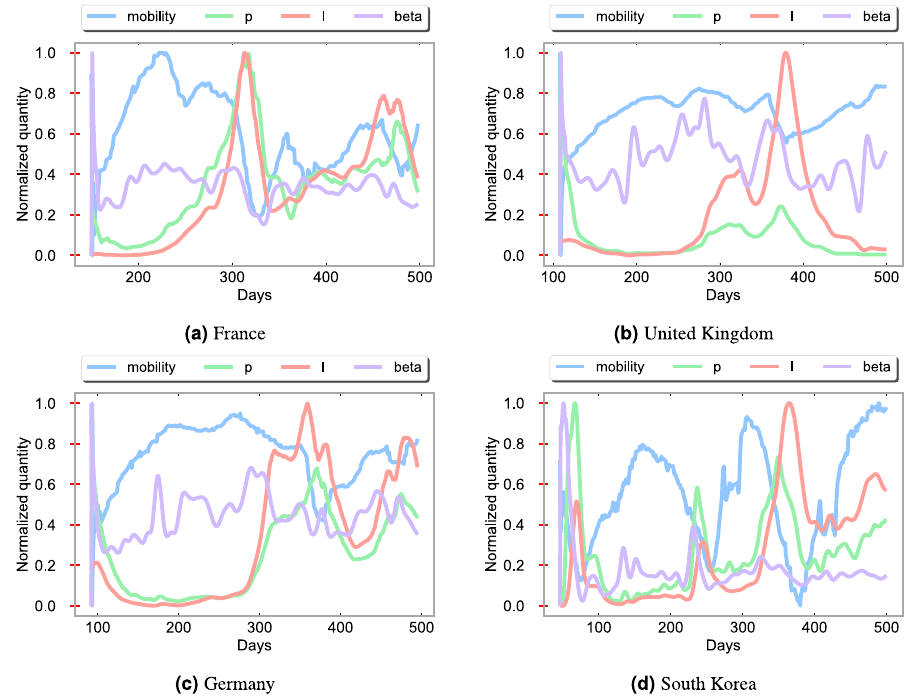
Figure 4. Plots of the normalized mobility values, positive test rate (p), infectious individual (I), and contact ratio ( β ) against the time (Days) for France, United Kingdom, Germany, and South Korea.